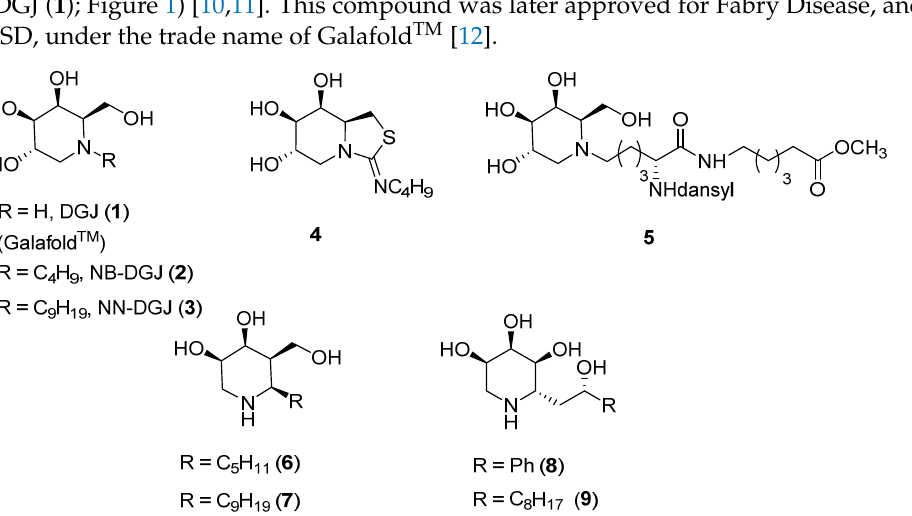
Figure 1. Structures of some imino- and azasugars inhibitors and chaperones of β -Gal. The ability of 1 to rescue the activity of mutant β -Gal up to 7-fold in human fibroblasts from patients with GM1 gangliosidosis was demonstrated in 2001 [13]. Since then, great